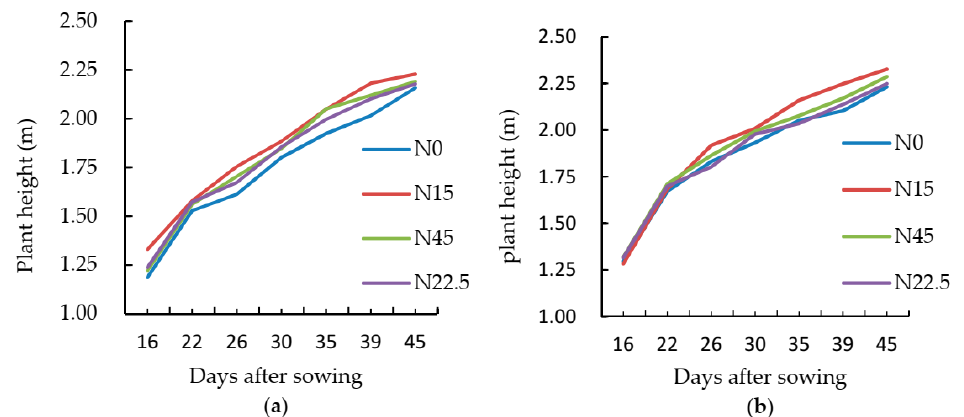
Figure 2. Variation trend of the digital surface model (DSM)-based plant heights. ( a ) XiangZhu No. 3 and ( b ) XiangZhu No. 7.